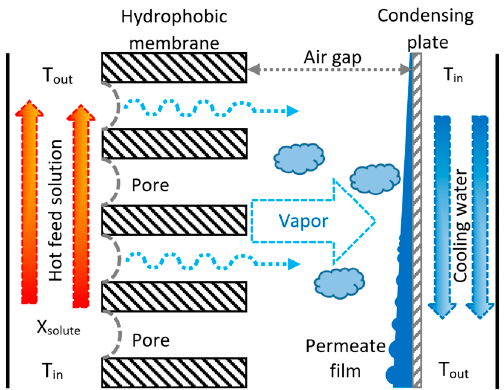
Figure 1. Schematic diagram of the AGMD separation process